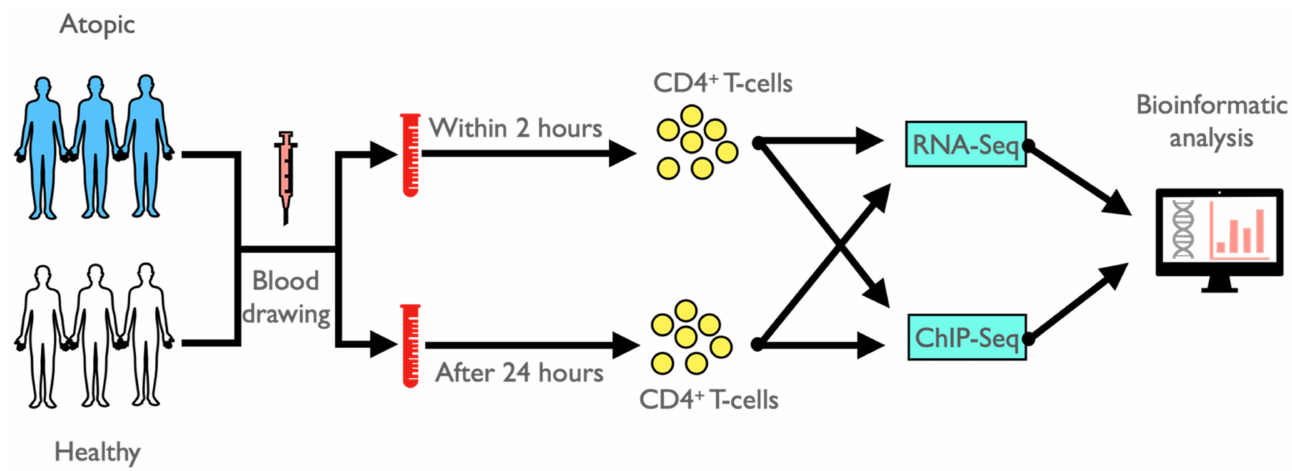
Figure 1. Schematic representation of the general study